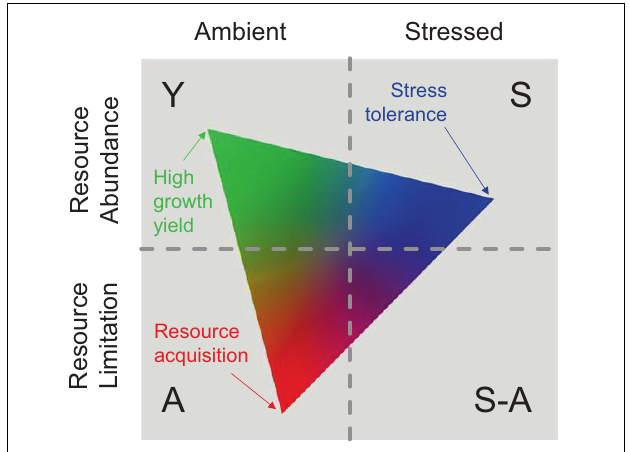
FIGURE 7 | A conceptual figure of the Y-A-S framework. The Y-A-S triangle was arrayed on the combinations and represented a hypothesized particular system. The meaning of the three strategies, including the high yield (Y: maximizes growth efficiency as a result of reduced investments in stress tolerance and resource acquisition), the resource acquisition (A: preferential investment for optimized resource acquisition), and stress tolerance (S: preferential investment in stress tolerance mechanisms) (Malik et al.,